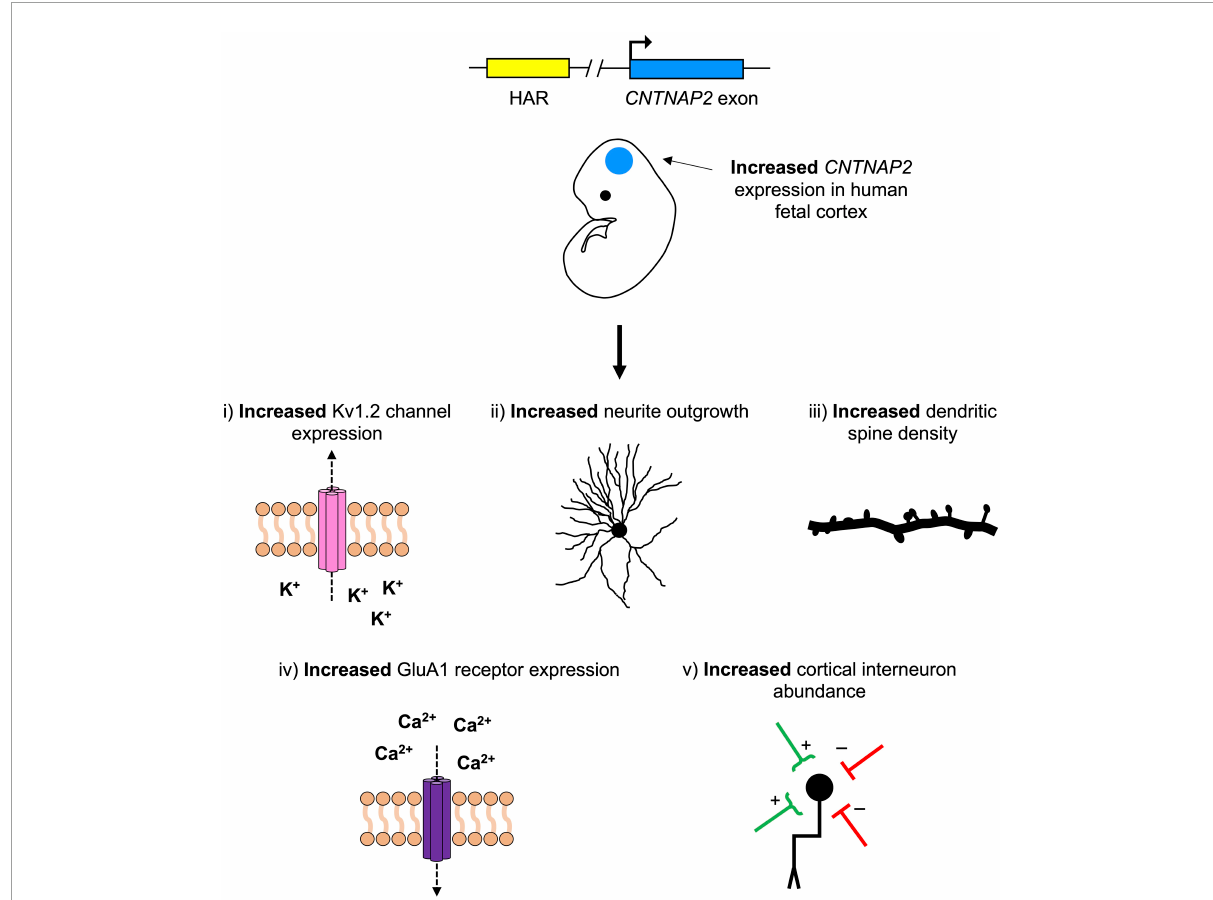
FIGURE6 A hypothetical model for the role of contactin-associated protein-like 2 ( CNTNAP2 ) in human neurodevelopmental disease and cerebral cortex evolution. Mutations that decrease CNTNAP2 expression [e.g., nonsense mutations or those disrupting a human accelerated region (HAR)] cause reductions in (1) potassium channel (Kv1.2) expression, (2) neurite branching, (3) dendritic spine density, (4) glutamate receptor (GluA1) expression, and (5) cortical interneuron abundance. Since CNTNAP2 has higher expression in the cortex of humans than in non-human primates, the opposite (i.e., increases in these features) may have contributed to differences in human versus non-human primate brain function. One (or more) of the CNTNAP2 HARs may be driving this increase in expression by functioning as an enhancer with human-specific